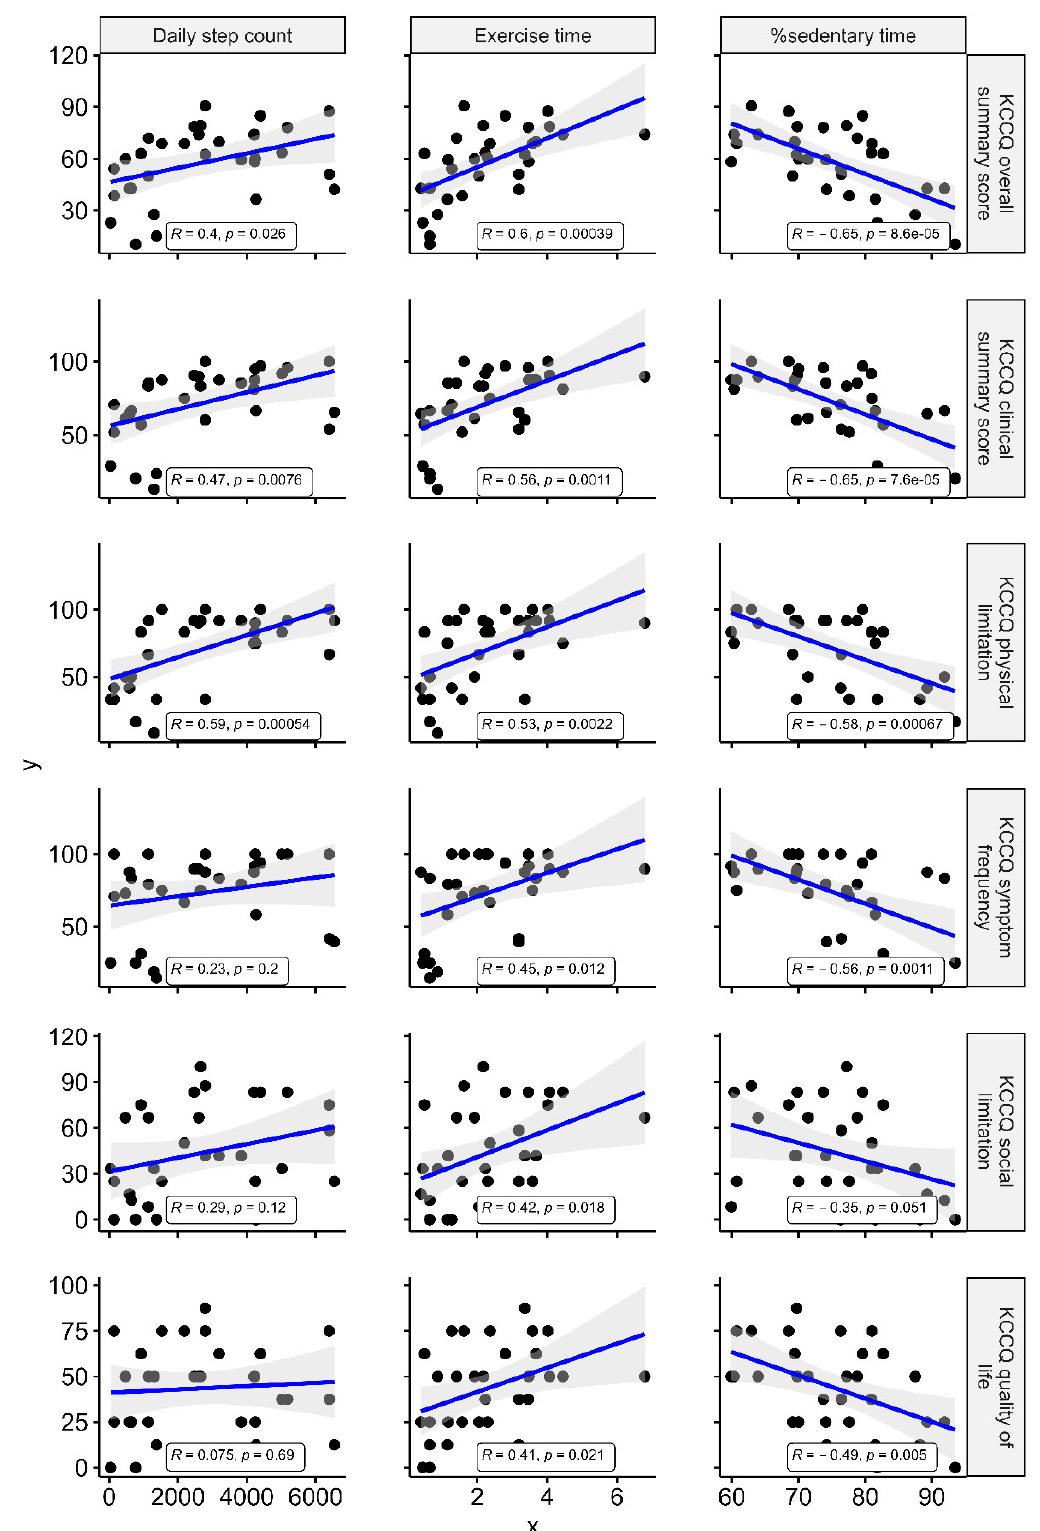
Figure 3. Correlation of accelerometer-measured physical activity with the Kansas City Cardiomyopathy Questionnaire. R represents Pearson’s correlation coefficient. KCCQ = Kansas City Cardiomyopathy Questionnaire; OSS = overall summary score; CSS = clinical summary score.